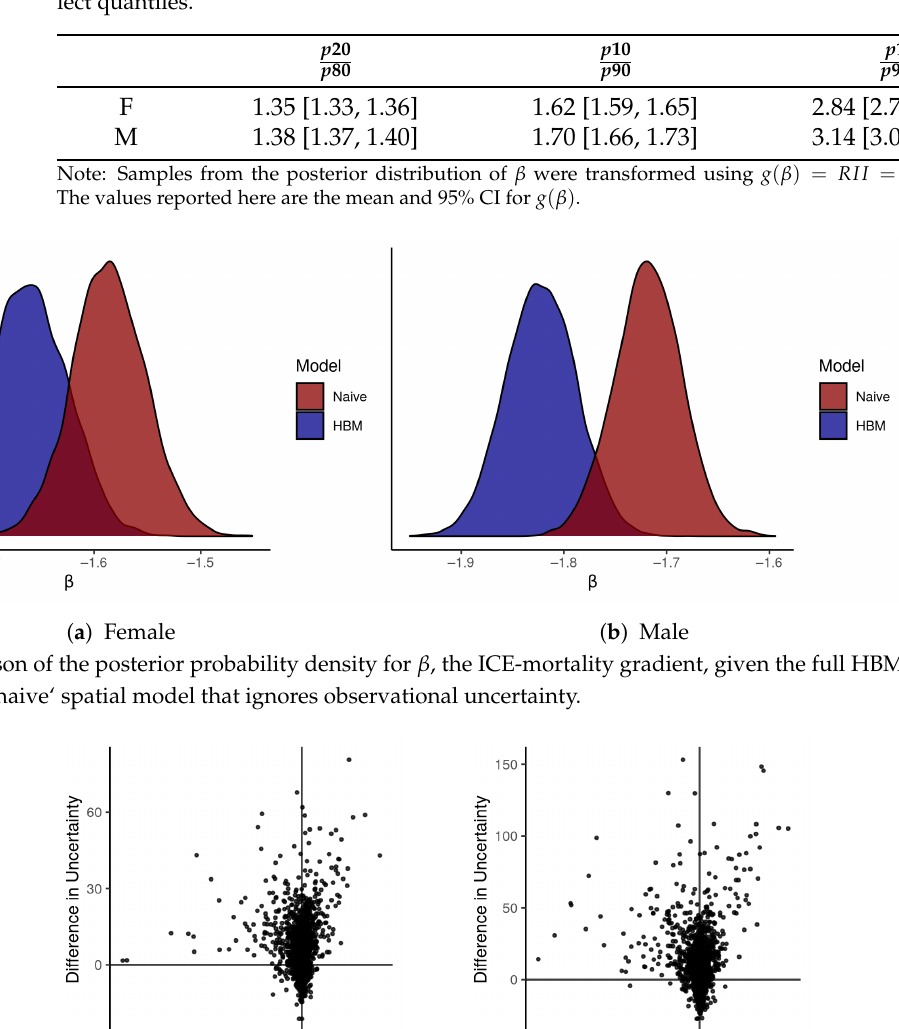
Figure 13. Differences in posterior distributions of mortality rates naive model (difference = full-naive). The mean refers to the mean of the posterior distribution of each rate; uncertainty is measured by the width of the corresponding 95%